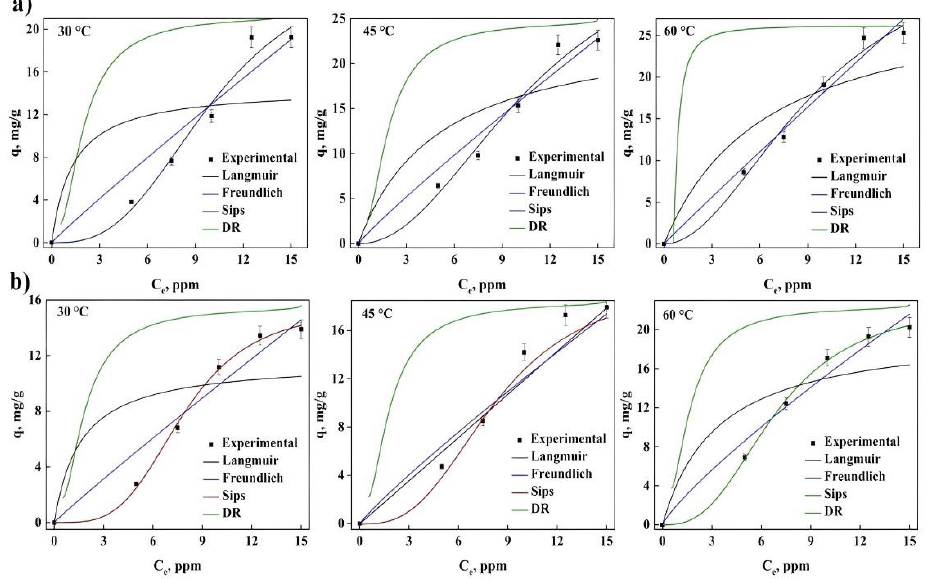
Figure 3. Fitting for the experimental data of PR adsorption at different temperatures employing different isotherm models: ( a ) WLW and ( b ) NWL.